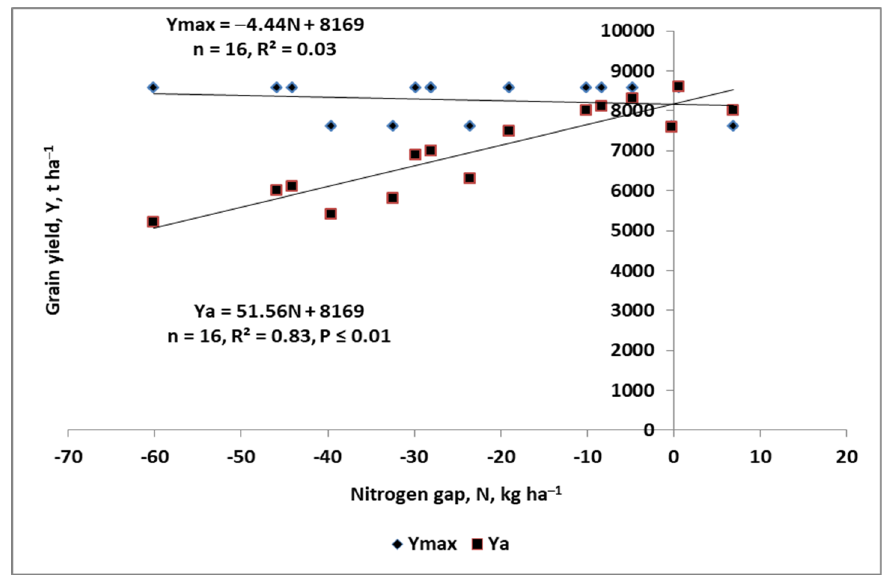
Figure 8. The trends in the actual and maximum attainable yields in response to the nitrogen gap in winter wheat. Legend: NG—nitrogen gap; Y attmax —maximum attainable yield; Y a —actual yield. winter wheat. Legend: NG —nitrogen gap; Y attmax —maximum attainable yield; Y a —actual